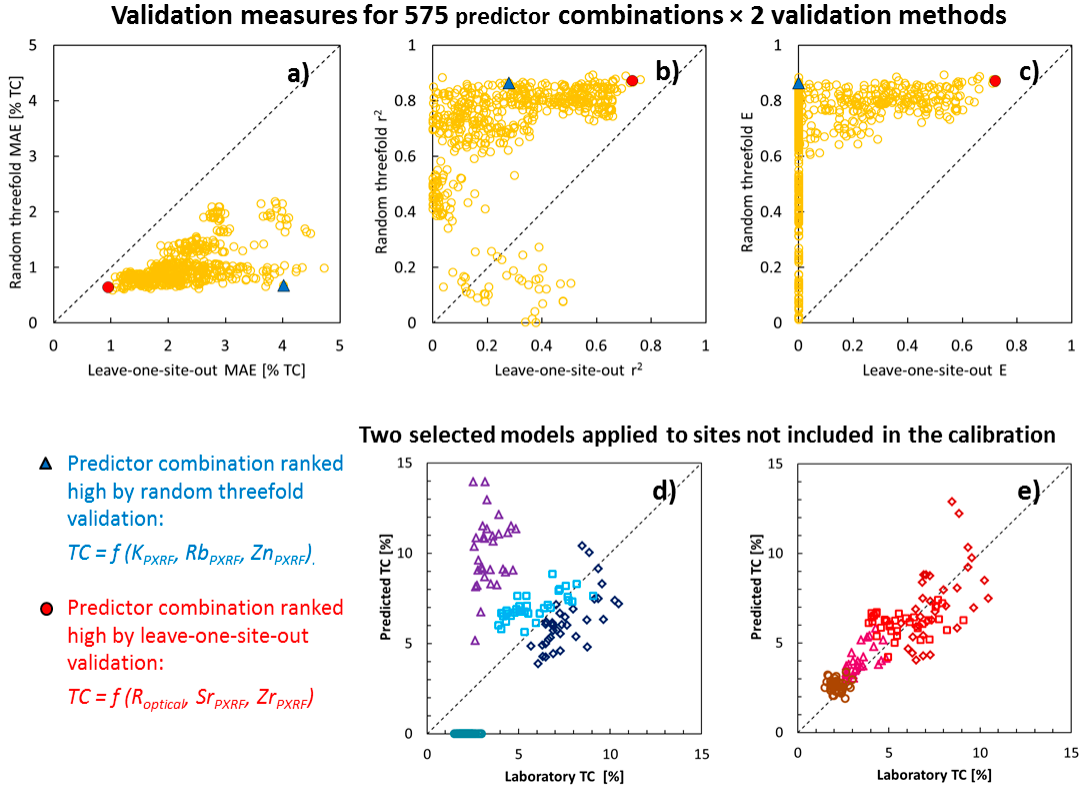
Figure 6. Comparison of validation methods. In the upper row of plots ( a – c ), each point represents the validation of one prediction model for total carbon (TC). There are 575 points per plot, each representing a unique predictor combination. The y -axes show results from the random threefold validation, while the x -axes show results from the leave-one-site-out validation. For two of the predictor combinations, the best in the leave-one-site-out validation (red-filled circle marker) and the best in the random threefold validation (blue-filled triangle marker), predicted values are plotted against measured values (leave-one-site-out method) in plots ( d , e ). The different shapes of the symbols in ( d , e ) indicate different sites. MAE = mean absolute error, r 2 = the coefficient of determination for a linear regression between the predicted and the measured value. Some values were out of the range for the plots and values <0 were set to